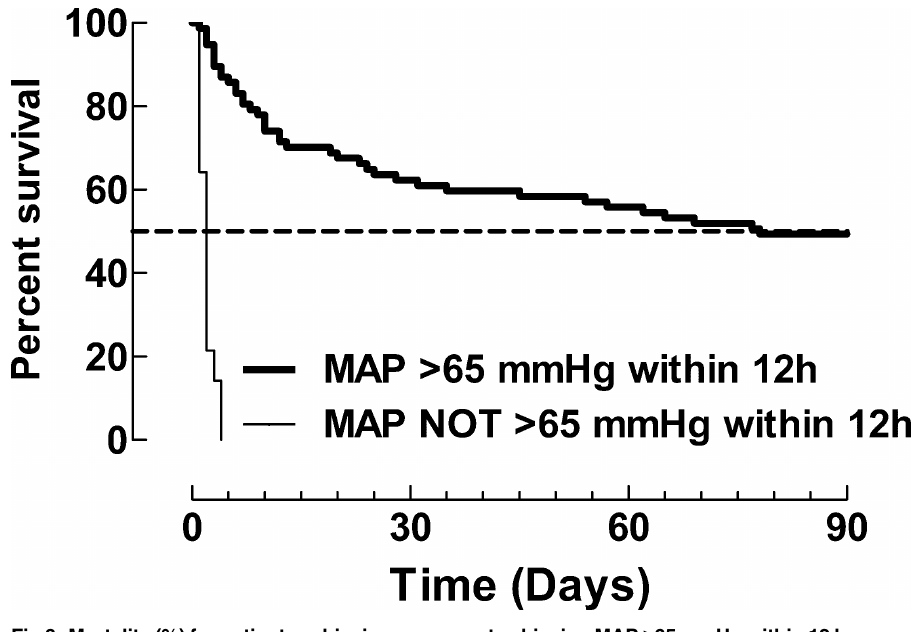
Fig 3. Mortality (%) for patients achieving versus not achieving MAP > 65 mmHg within 12 hours. Kaplan-Meier curve with mortality (%) as outcome for patients achievingversus not achievingMAP > 65 mmHg within 12 hours. p < 0.0001(Gehan-Breslow-Wilcoxon Test).